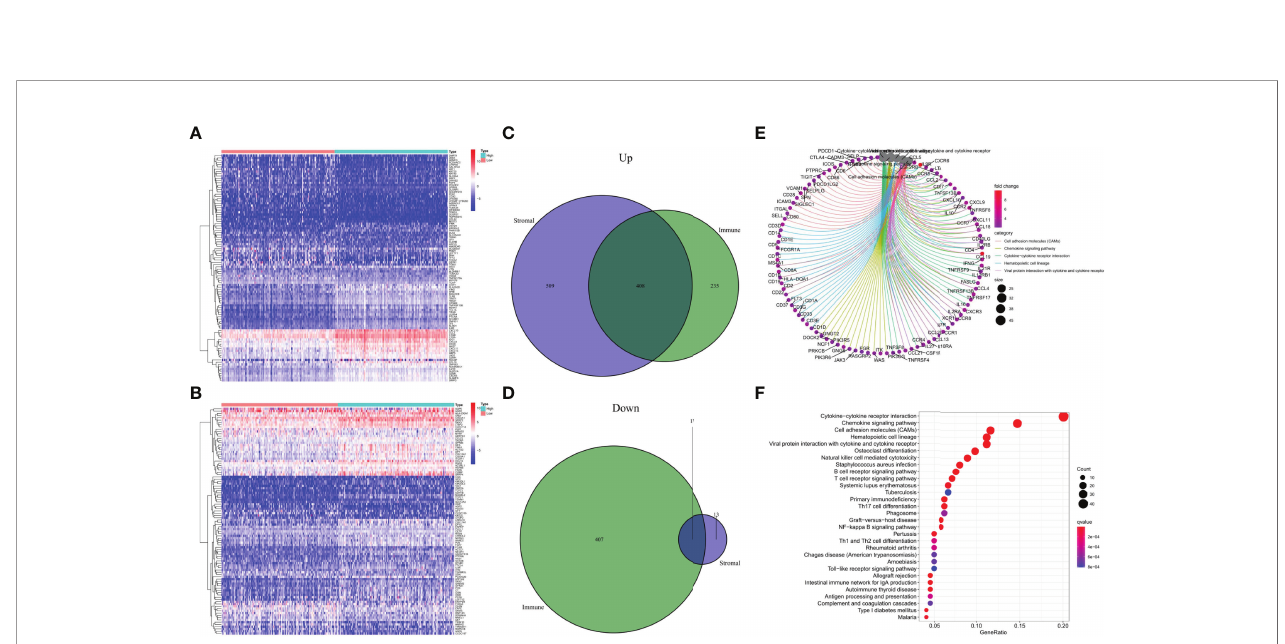
FIGURE 4 | Heatmaps, Venn plots, and enrichment analysis of GO and KEGG for DEGs. (A) Heatmap for DEGs generated by comparison of the high score group vs. the low score group in ImmuneScore. Row name of heatmap is the gene name, and column name is the ID of samples which not shown in plot. Differentially expressed genes were determined by Wilcoxon rank sum test with q = 0.05 and fold-change>1 after log2transformation as the signi fi cance threshold. (B) Heatmap for DEGs in StromalScore, similar with (A) . (C, D) Venn plots showing common up-regulated and down-regulated DEGs shared by ImmuneScore and StromalScore, p < 0.05 and fold-change>1 after log 2 transformation as the DEGs signi fi cance fi ltering threshold. (E, F) GO and KEGG enrichment analysis for 425 DEGs, terms with p < 0.05 were believed to be enriched signi fi